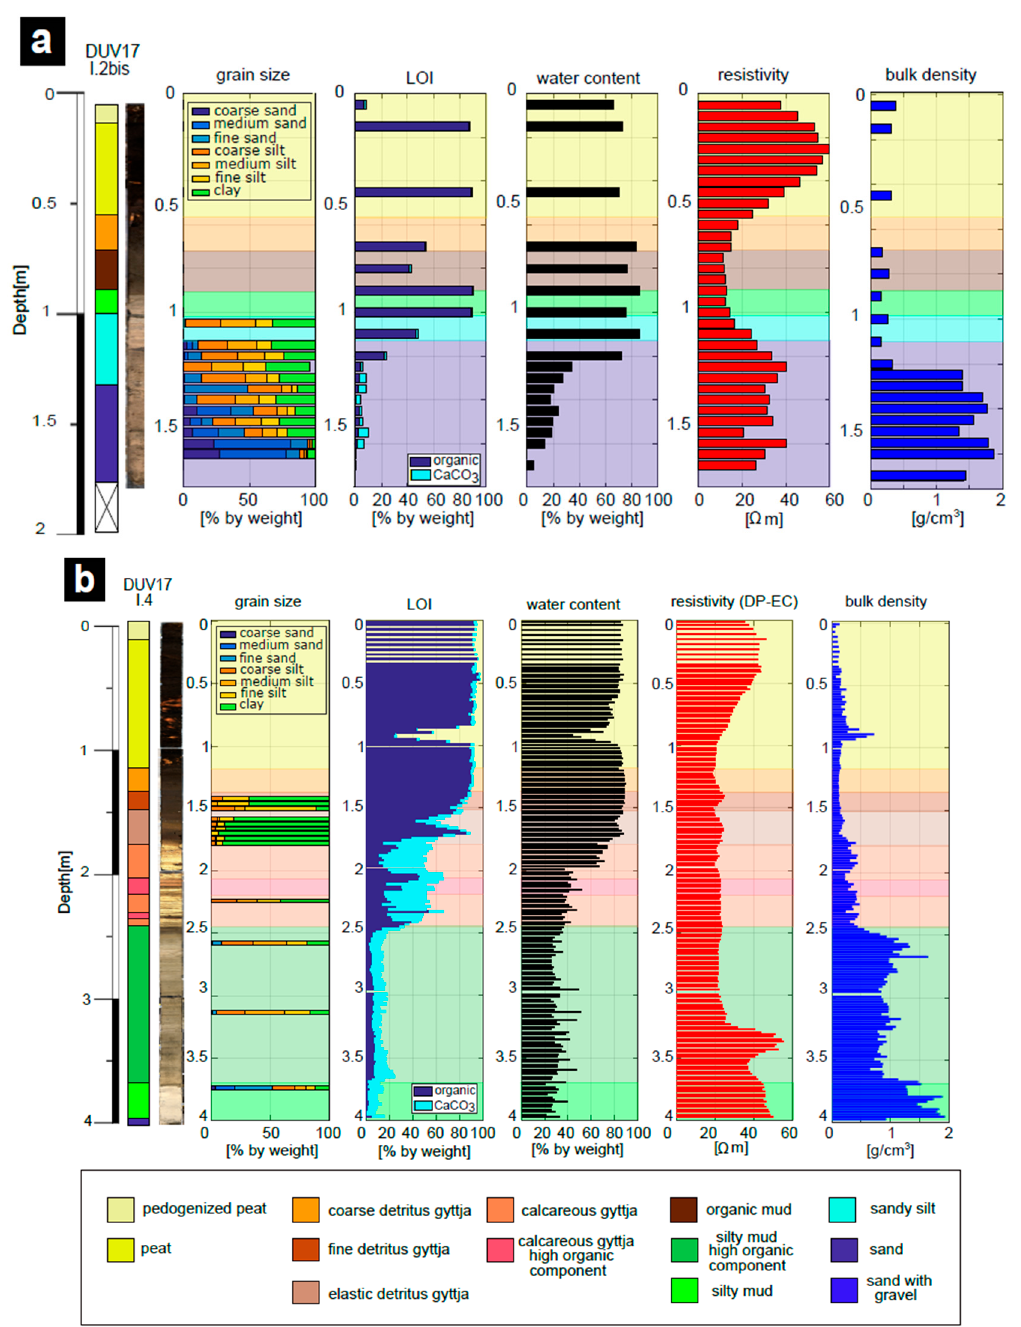
Figure 3. Laboratory analysis belonging to core I.2bis ( a ) and I.4 ( b ). The different properties are shown in comparison with the stratigraphy.